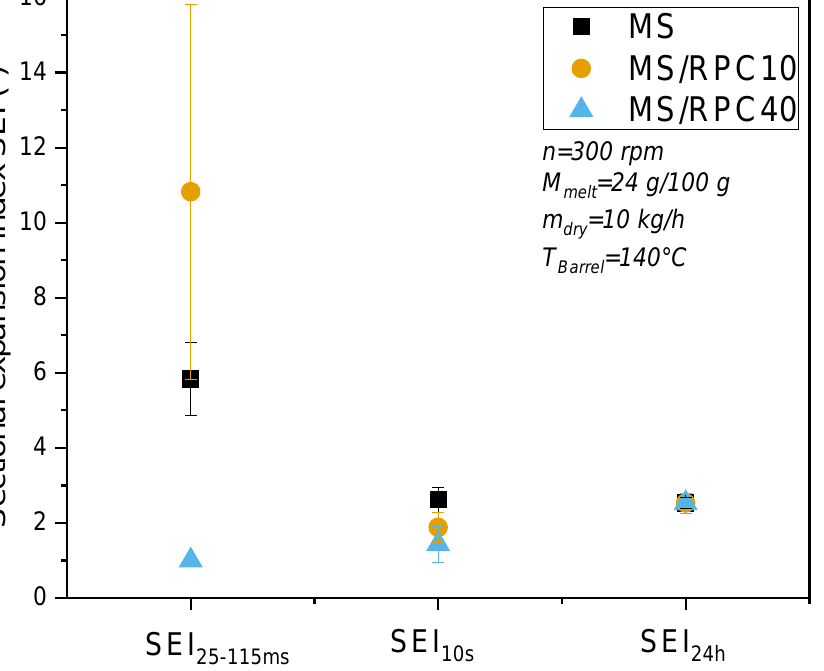
Figure 3. Intermediate sectional expansion index (SEI 10s ) of maize starch (MS) extruded as a pure component or in blends with 10 or 40 g/100 g (w.b.) rapeseed press cake (RPC). Samples were processed at a barrel temperature (T Barrel ) of 100, 120 or 140 °C, a mass flow rate (m dry ) of 10 kg/h, a moisture content (M melt ) of ( a ) 24 g/100 g (d.m.) or ( b ) 29 g/100 g (d.m.) and a screw speed (n) of 300 rpm.